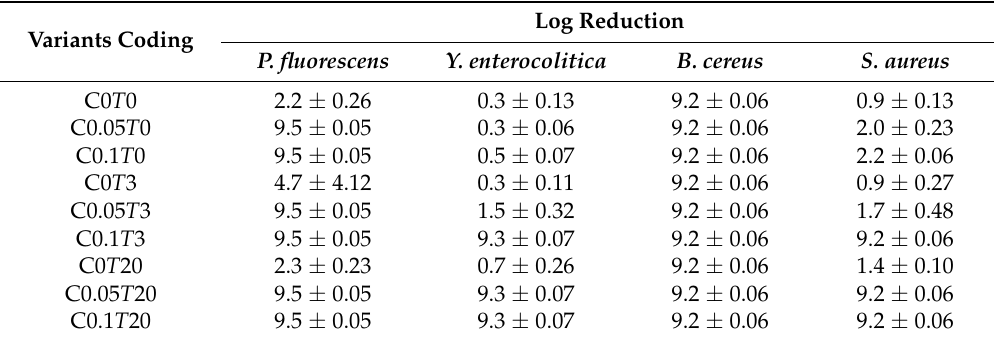
Table 2. Effects of cellulase addition (C, %) and reaction time ( T , h) on the antimicrobial properties of film-forming hydrosols.